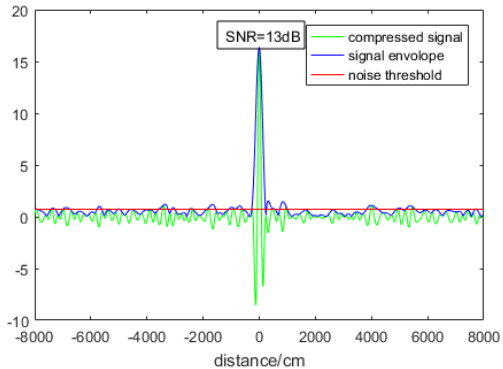
Figure 8 . Sensitivity test result. Figure 8. Sensitivity test